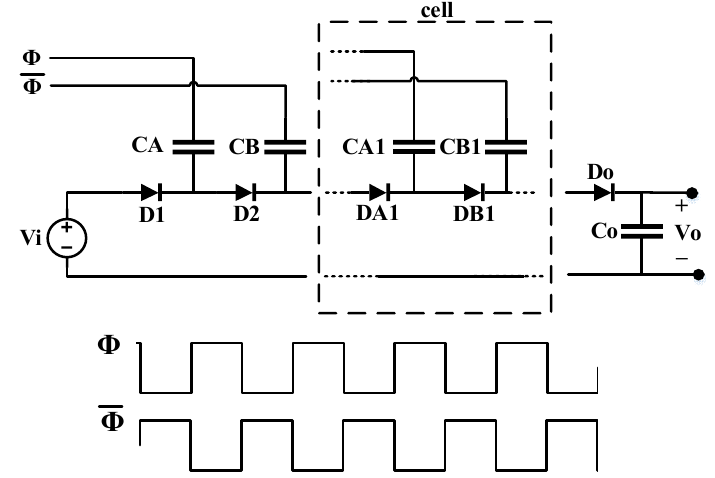
Figure 6. Dickson Figure 6. Dickson converter. Figure 6. Dickson converter.